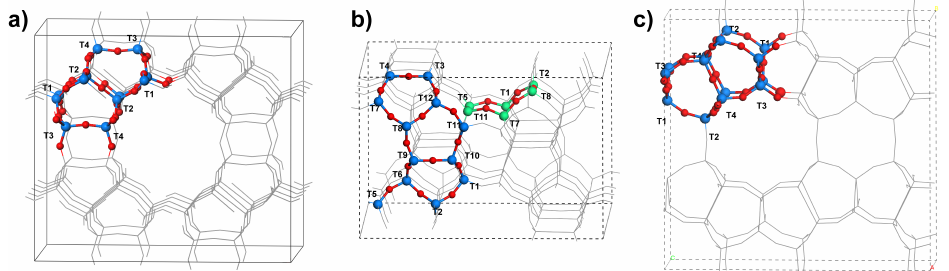
Figure 1. Annotated Si positions in framework of ( a ) MOR, ( b ) MFI, ( c ) FER; blue spheres—the non-equivalent Si positions, red spheres—O atoms, green spheres—commonly regarded set of Si atoms exposed to large channels. After [11], copyright by Springer International Publishing, with